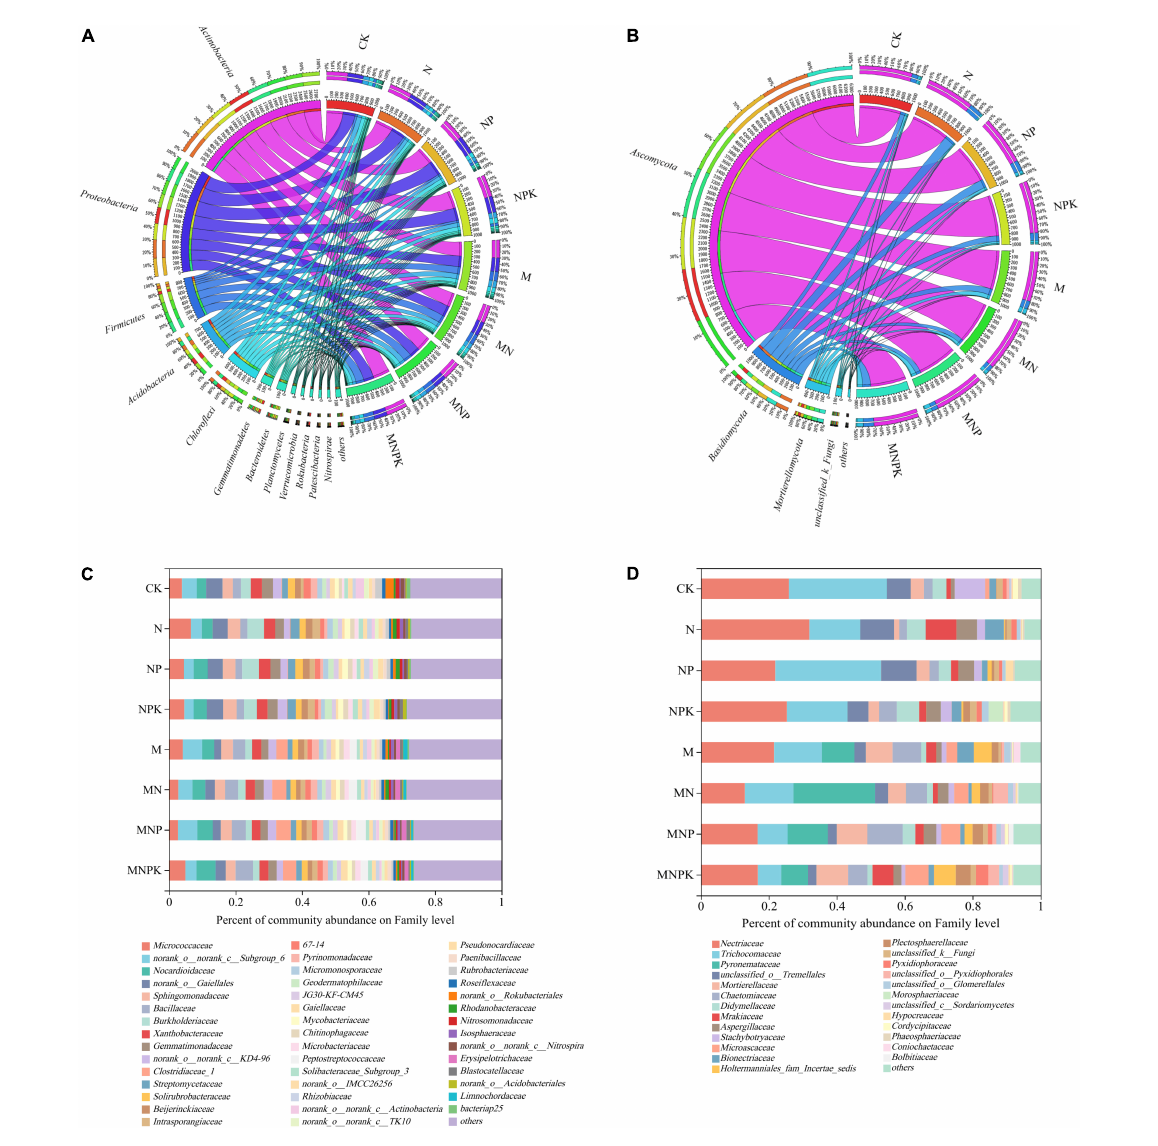
FIGURE1 Relative abundances of the rhizosphere microbial community composition on phylum and family levels under different treatments. (A) Bacterial community on phylum level. (B) Fungal community on phylum level. (C) Bacterial community on family level. (D) Fungal community on family level. CK, no fertilizer; N, chemical N fertilizer; NP, chemical N and P fertilizer; NPK, chemical N, P, and K fertilizer; M, pig manure only; MN, pig manure plus chemical N fertilizer; MNP, pig manure plus chemical N and P fertilizer; MNPK, pig manure plus chemical N, P, and K